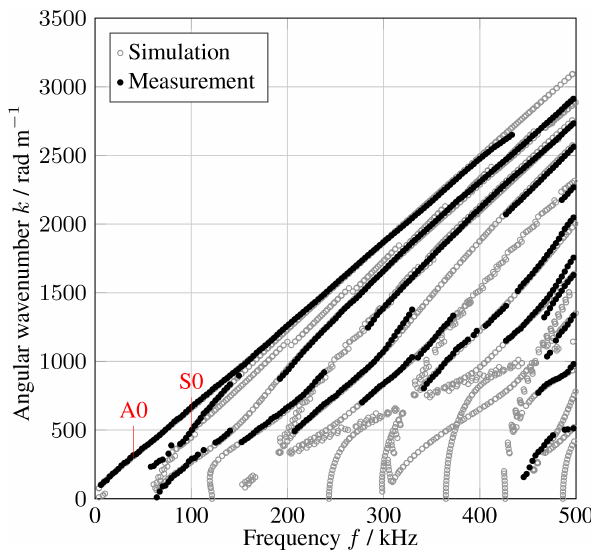
Figure 14. Comparison of simulated and measured dispersion dia-